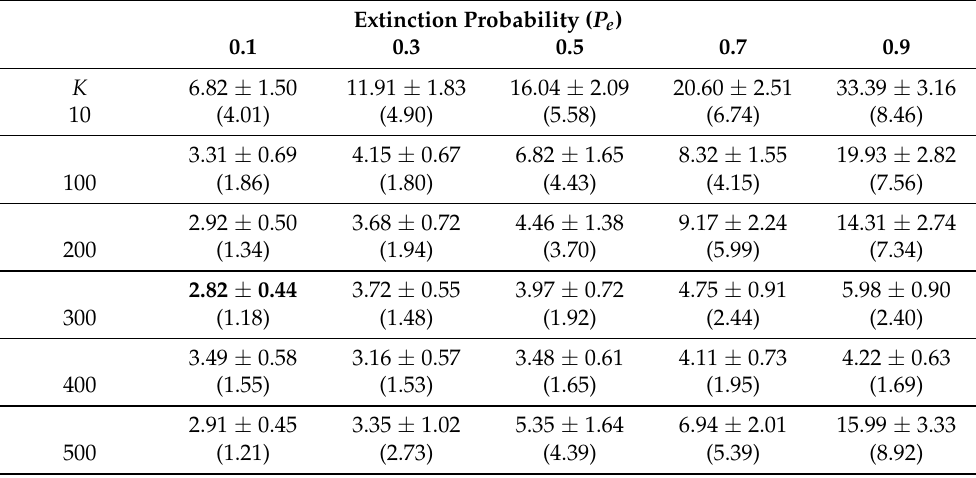
Table 3. Fitness results of SDEP with random extinction on Rastrigin ( K is the stagnant counter); 95% confidence interval is presented after ± sign, and standard deviation is presented inside parenthesis. Minimum results are in bold font.